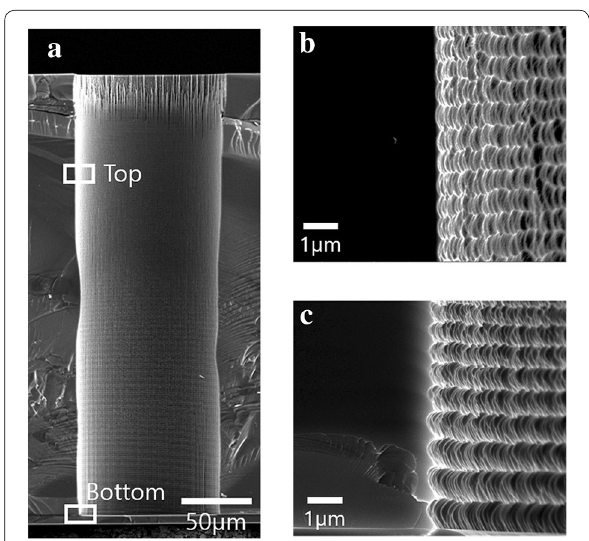
Fig. 2 Cross‑section SEM images of a DRIE trench before scallop smoothing. a SEM image of the entire trench. Magnified SEM images of the sidewall ( b ) near the top area and ( c ) at the bottom of the